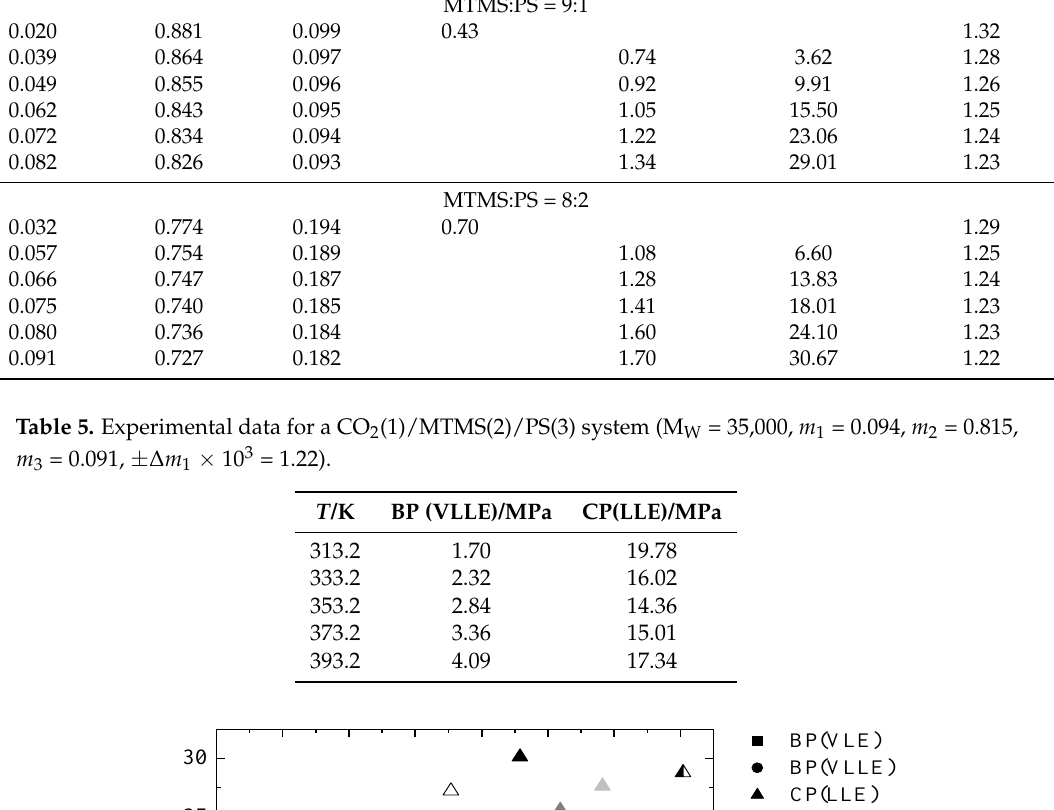
Table 4. Experimental data for a CO 2 (1)/MTMS(2)/PS(3) system (M W = 250,000, 313.2 K). m 1 (CO 2 )/-